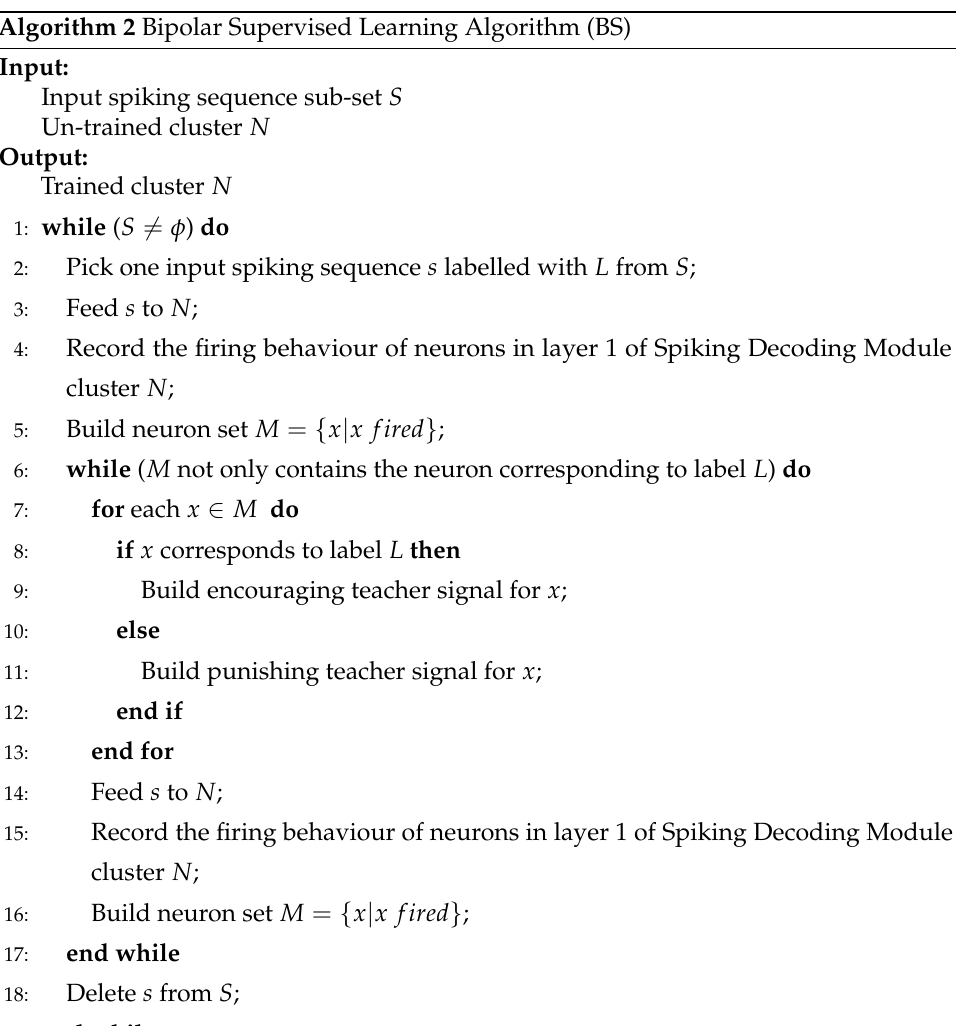
Algorithm 2 Bipolar Supervised Learning Algorithm (BS)